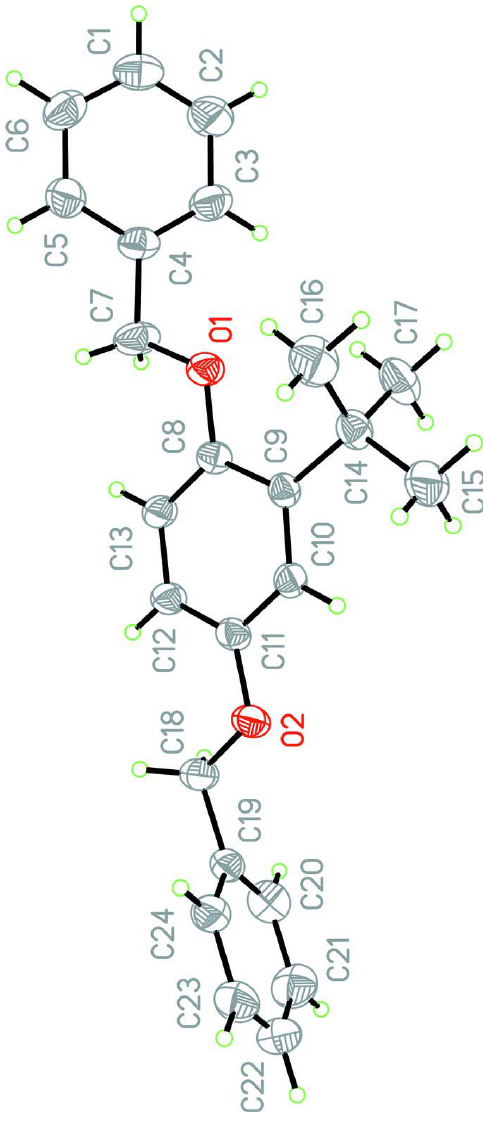
Figure 1 A view of the molecular structure of (I) with the atom numbering scheme. Displacement ellipsoids are drawn at 30% probability level. H atoms are presented as a small spheres of arbitrary